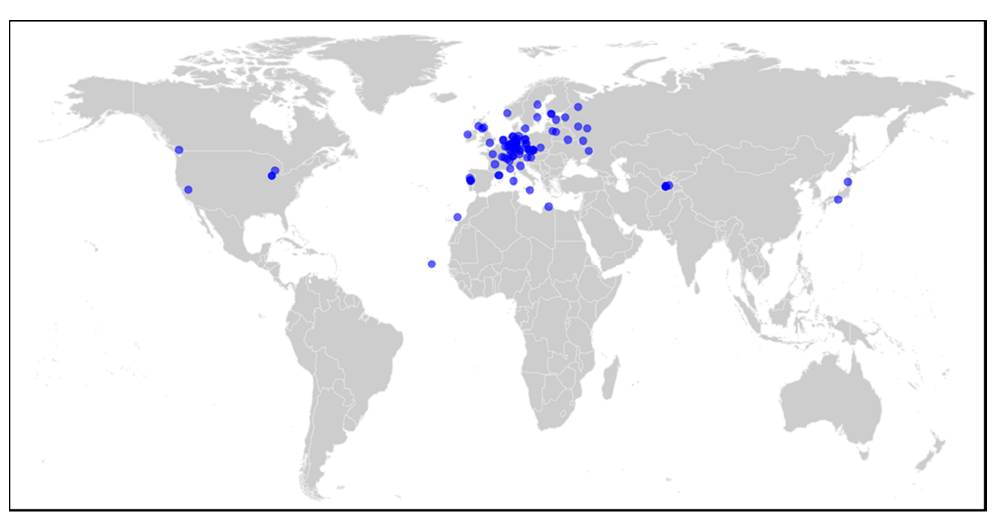
Figure 1. Geographic origin of the 102 Arabidopsis accessions used in this study. Each blue dot indicates the origin of one accession.